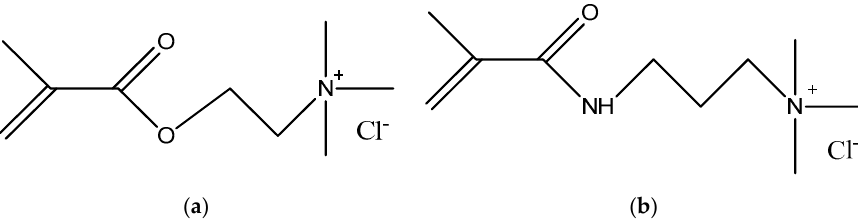
Scheme 1. Structures of the cationic monomers : ( a ) 2-(methacryloyloxyethyl)trimethylammonium